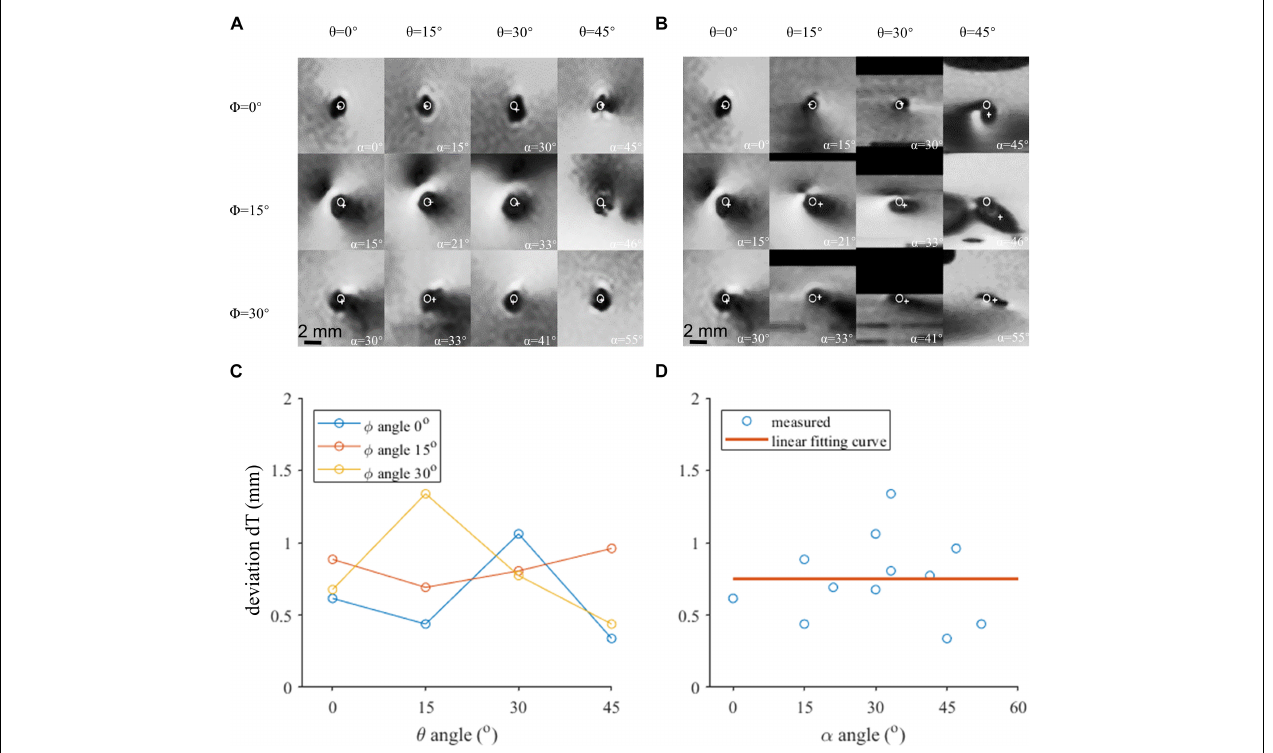
FIGURE 3 | The axial view of the contact 0 artifact in various orientations. (A) Image reconstructed perpendicular to the lead axis. (B) Image reconstructed perpendicular to the B0 field. (C) Localization deviation assessed in the axial view under different θ and ϕ angles. (D) The localization deviation of contact 0 with respect to α , reconstructed perpendicular to the B0